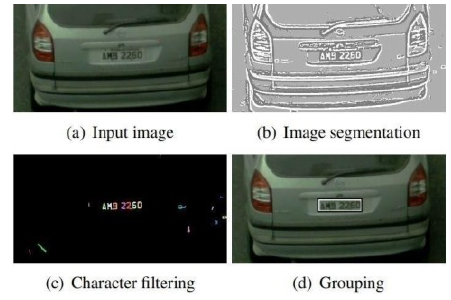
Fig. 8: License plate detection by